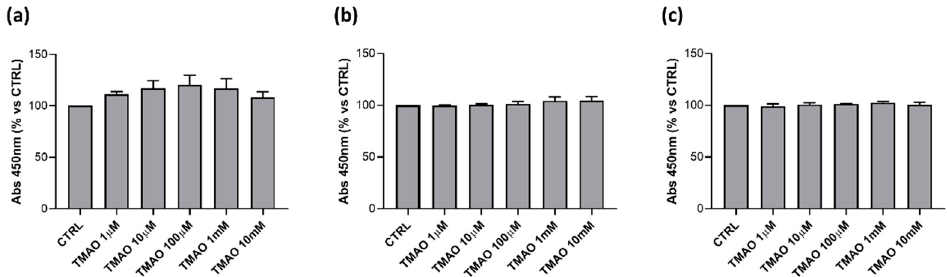
Figure 1. TMAO does not impact BAE-1 viability. BAE-1 were treated with different concentrations of TMAO that showed no cytotoxic effect after ( a ) 24 h, ( b ) 48 h, and ( c ) 72 h (n = 3 independent experiments).